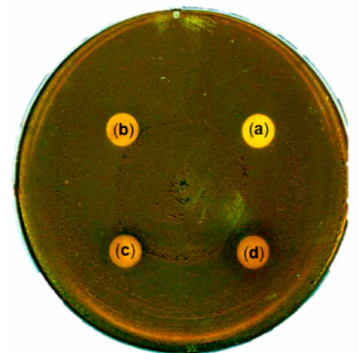
Figure 4. Antibacterial activity of TS extract. ( a ) DMSO; ( b ) 1 mg / disc of TS extract; ( c ) 2 mg / disc of TS extract; ( d ) 3 mg / disc of TS extract.